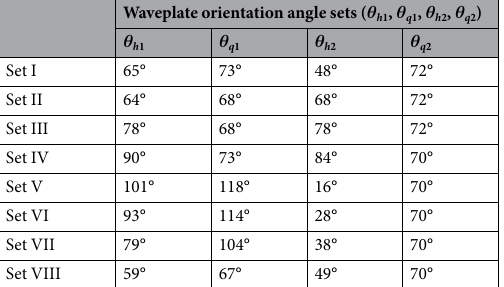
Waveplate orientation angle sets ( θ h 1 , θ q 1 , θ h 2 , θ q 2 ) θ h 1 θ q 1 θ h 2